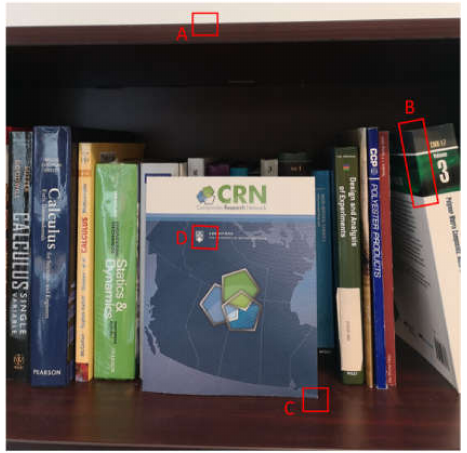
Figure A1. A mockup photograph used first to analyze the e ff ects of di ff erent image filtering algorithms on an ultra-high-quality base image. The image was selected due to its multiple features that are relevant to the conducted cases of fabric Micro-CT images. Namely, these included: (A) high contrast regions with high gradients along the axes of pixel distribution (x, y directions), (B) similar high contrast regions at o ff -axis orientations, (C) curved edges with parallel texture features in the foreground and depth-of-blur applied to the background, as well as (D) high-aspect-ratio linear features in low-contrast regions. Having multiple regions in various combinations allowed for the independent appraisal of global and local e ff ects of the filtering methods, to better choose which would be suitable for the case study at